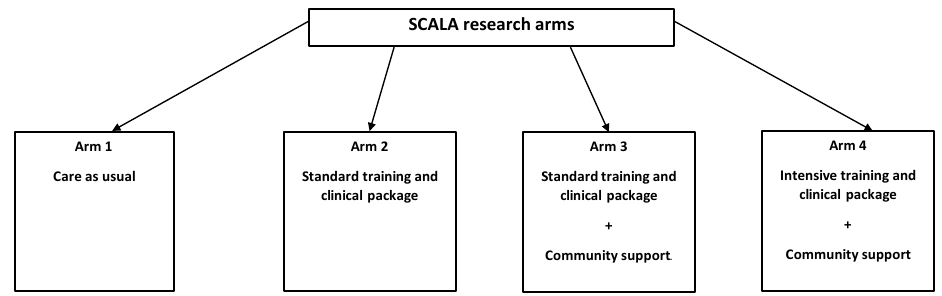
Figure 1. Implementation strategies in the SCALA research arms.